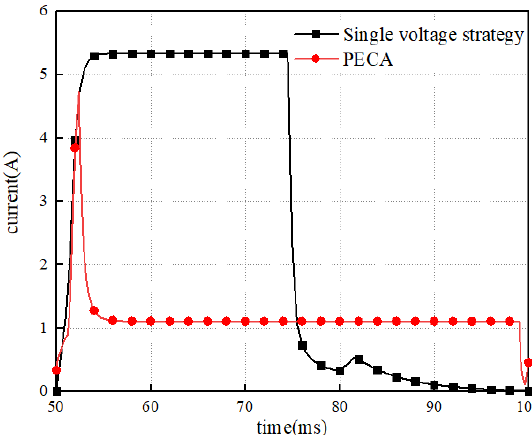
Figure 9. The current curve in two driven strategies.